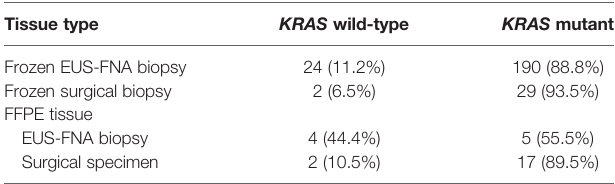
TABLE 1 | KRAS mutation rates in fresh frozen EUS-FNA, surgical and FFPE tissue